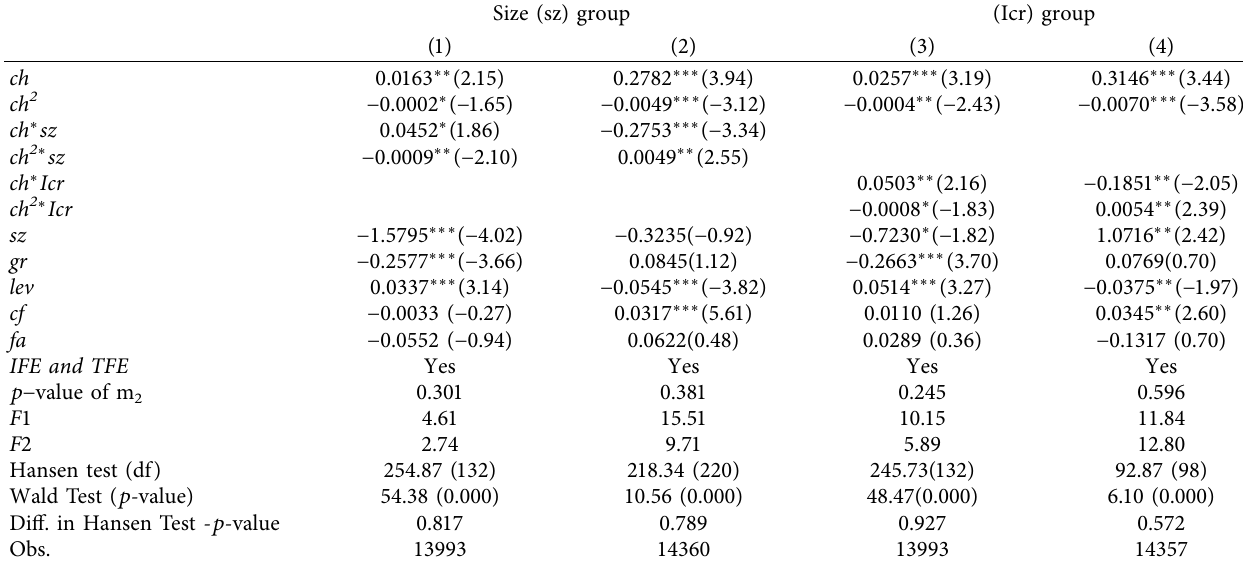
Table 5: Regression results for the effect of financial constraint on cash holding and corporate performance relationship.